Question: Summarize what this figure shows in one sentence.
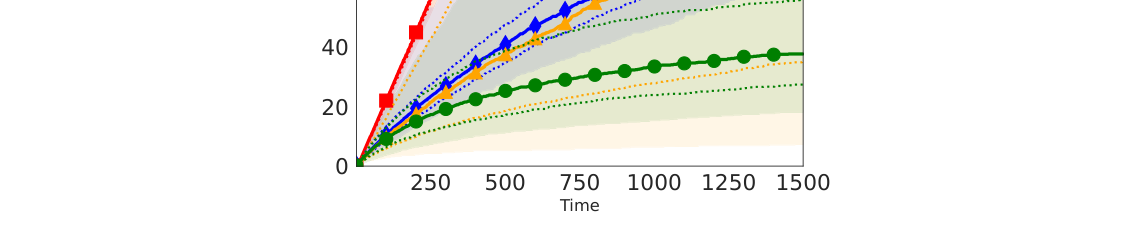
Answer: 1 – Left: two-armed Gaussian expectile bandit. Center: two-armed linear expectile bandit with R3 contexts and expectile-based asymmetric noises. Right: two-armed Bernoulli entropic risk bandit. Thick lines denote median cumulative pseudo regret over 500 independent replicates. Dotted lines denote the 25 and 75 pseudo regret percentiles. Shaded areas denote the 5 and 95 percentiles.